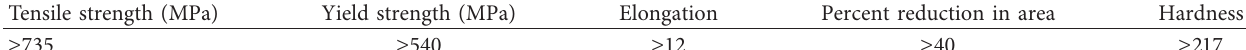
Figure 2: Specimen preparation process. (a) Stirring the mixture material. (b) The specified jointed mold. (c) Pouring the mixed synthetic rock-like material into the mold. (d) Standard specimens after 28 days of curing. Table 1: Mechanical parameters of the high-strength steel sheet.